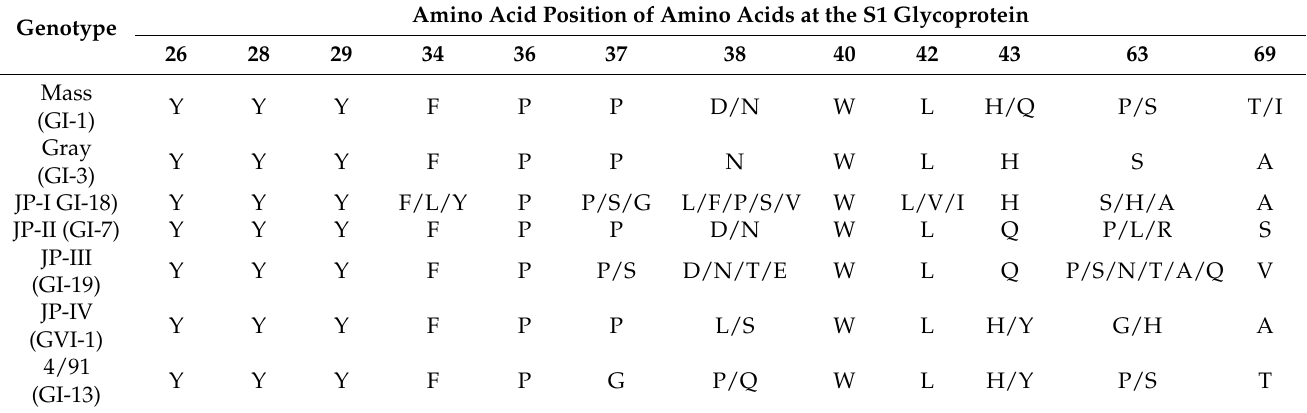
Table 3. Amino acids based on their relationship to the receptor-binding